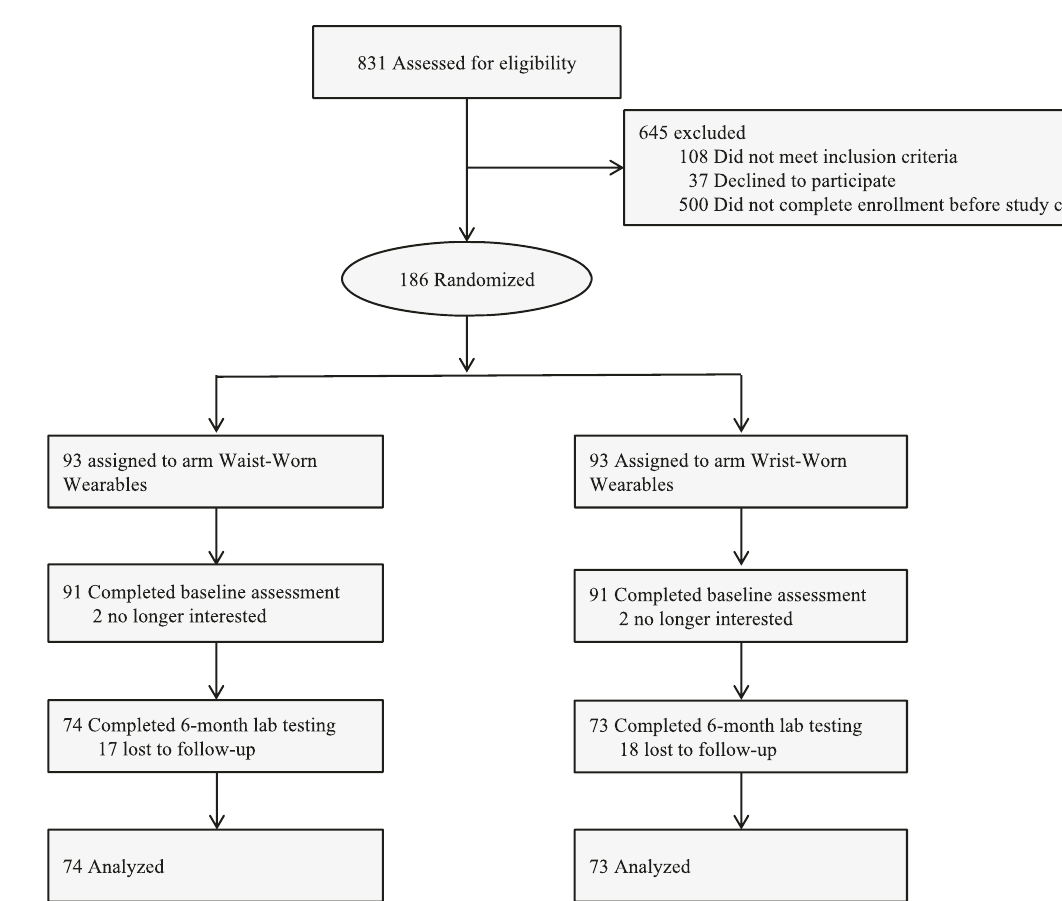
Fig. 1 Study fl ow diagram. Displayed is the fl ow of patients for each arm of the